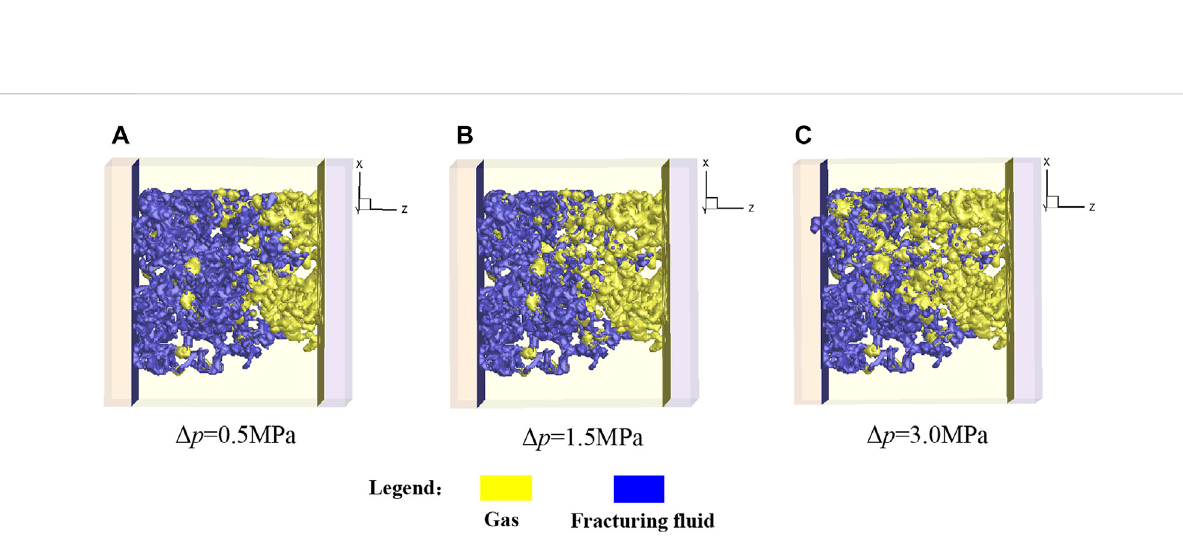
Frontiers in Earth